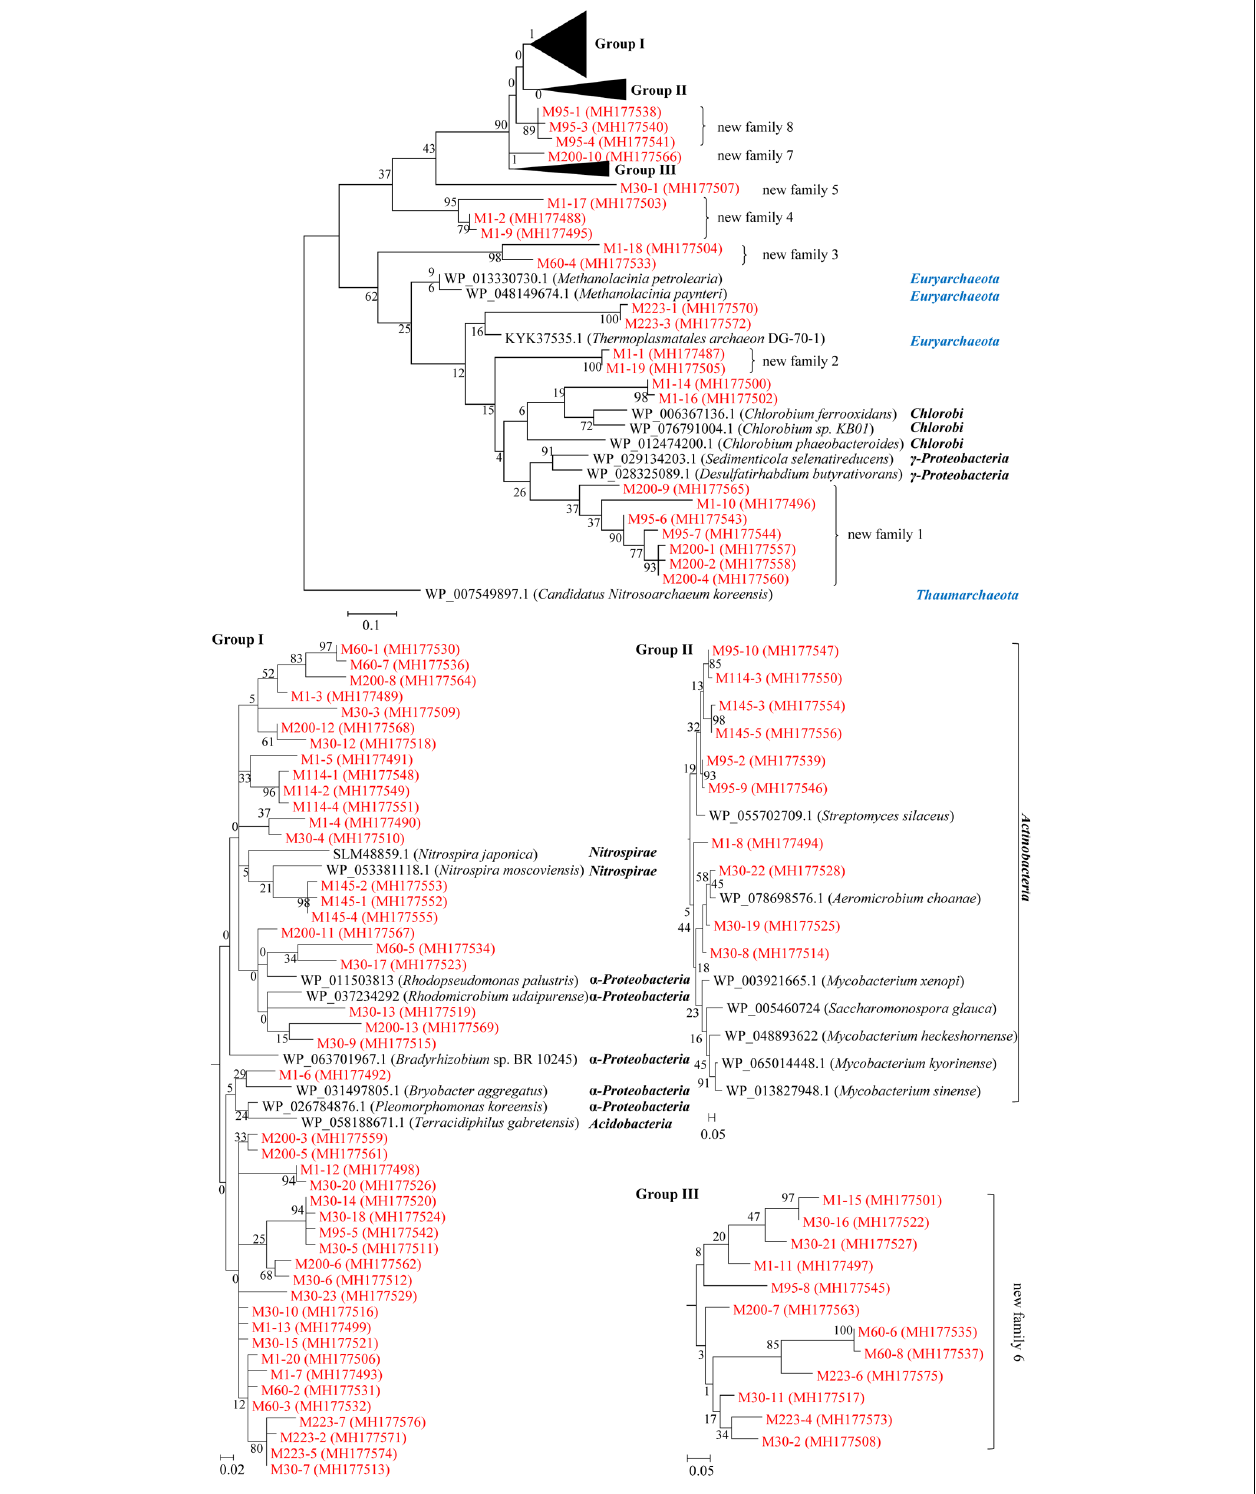
FIGURE 5 | Characterization of the ArsM proteins identified from microbial communities of the sediment samples from Jianghan Plain. Maximum likelihood tree constructed from the multiple sequence alignments of the obtained ArsM proteins from the sediment samples and their closely related homologues from other known microorganisms. All of the ArsM sequences in this study are shown in red; numbers on the branches are bootstrap values based on 1000 replicates; the scale bar represents the average number of substitutions per site.